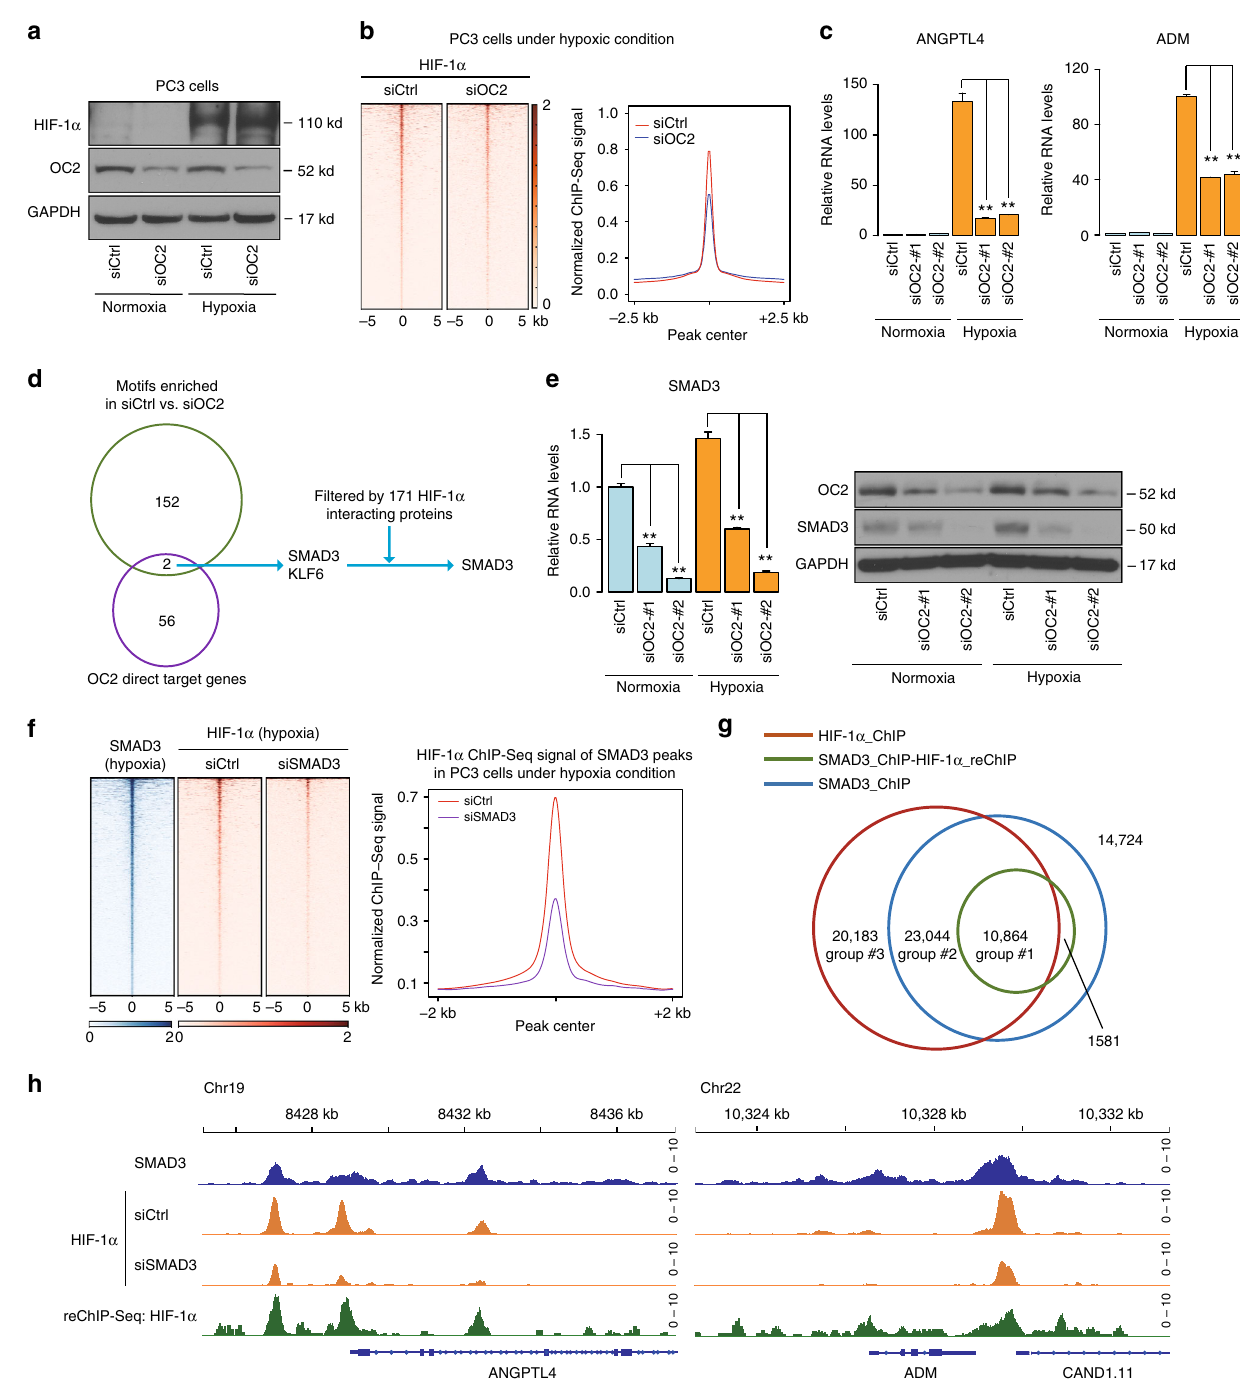
Fig. 3 ONECUT2 modulates HIF1 α binding to chromatin in NE-like PC3 cells. a Western blot of HIF1 α and ONECUT2 in PC3 cells under normoxic and hypoxic conditions. Two different siRNAs targeting ONECUT2 were mixed together for knockdown experiments. b Left panel: heatmaps show HIF1 α ChIP- Seq signal in PC3 cells under hypoxic conditions with and without knockdown of ONECUT2; right panel: pileup of HIF1 α ChIP-Seq signals centered at HIF1 α ChIP-Seq peaks center. c Expression of ANGPTL4 and ADM, two hypoxia-regulated genes, with and without knockdown of ONECUT2 in PC3 cells. d Schematic illustration of the analysis identifying SMAD3 as an ONECUT2 regulated HIF1 α co-factor. Genes identi fi ed in motifs enriched in HIF1 α binding sites and ONECUT2 target genes were further fi ltered by HIF1 α interacting protein list from BioGRID. ONECUT2 target genes were de fi ned as differentially expressed in ONECUT2 knockdown and control samples and with ONECUT2 binding sites nearby in PC3 cells under hypoxic conditions. e SMAD3 expression in response to ONECUT2 silencing in PC3 cells. f SMAD3 and HIF1 α binding sites with and without silencing of SMAD3. g The overlap of SMAD3 ChIP-Seq, HIF1 α ChIP-Seq and SMAD3-HIF1 α ChIP-re-ChIP-Seq peaks. h SMAD3 ChIP-Seq, HIF1 α ChIP-Seq and SMAD3-HIF1 α ChIP-re-ChIP-Seq signal near the promoter regions of hypoxia-induced genes ANGPTL4 and ADM. Error bars indicate s.d. from at least two technical replicates. P -value is calculated by one-way ANOVA. **: P < 0.01. Source data are provided as a Source Data fi